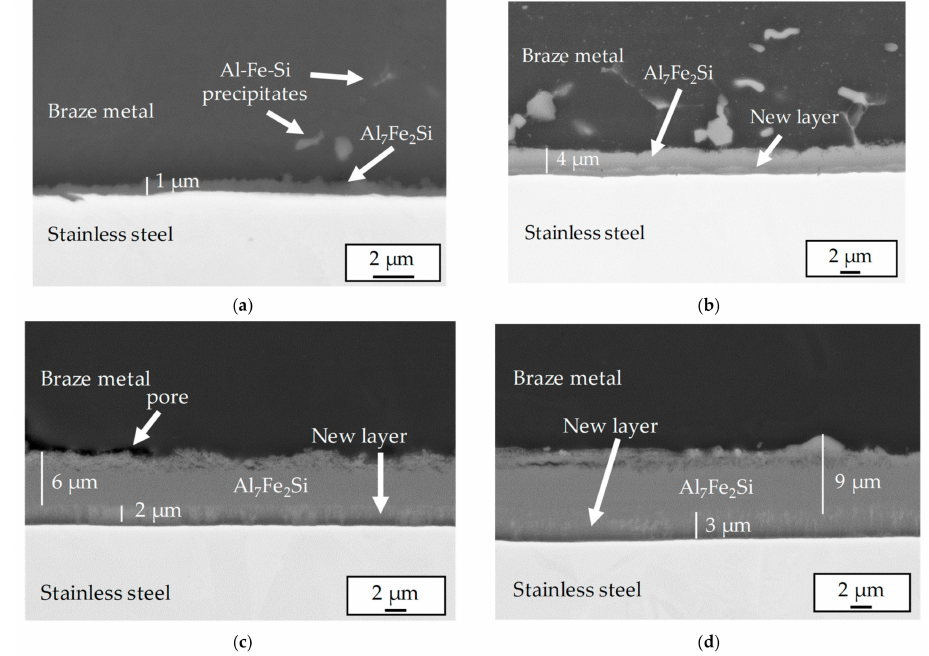
Figure 4. SEM images of the reaction zones after brazing ( a ) and after long-term thermal exposure experiments at temperature of 500 ◦ C for 6 h ( b ), for 48 h ( c ) and for 120 h ( d